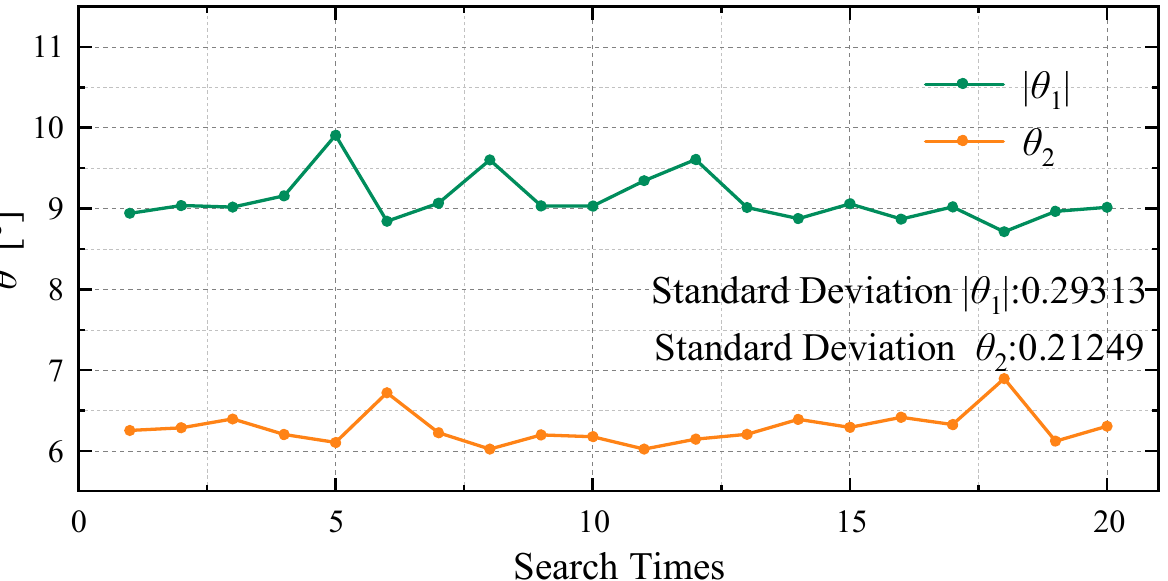
Figure 10. The fluctuations of θ 1 and θ 2 for 20 calculations.